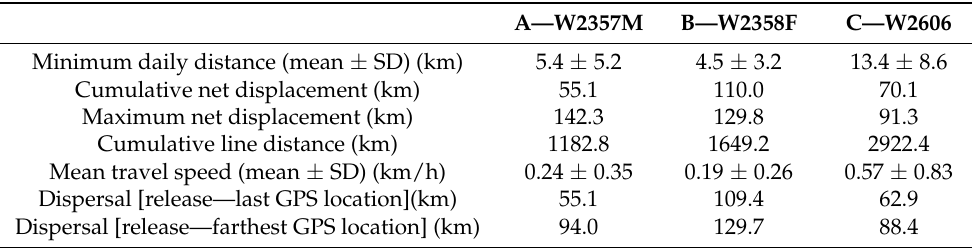
Table 1. Covered distances and mean travel speed (km/h) of three GPS-collared wolves in Northern Italy, 2019–2021.